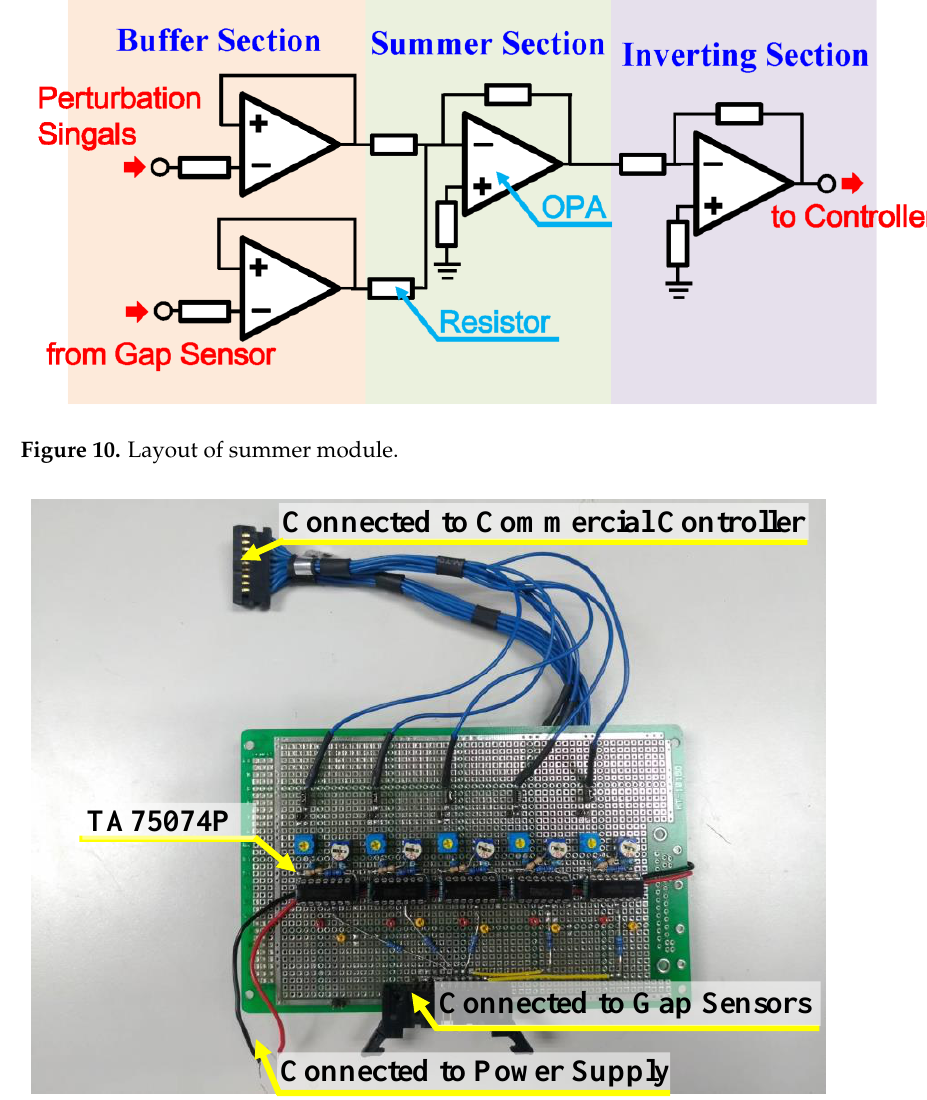
Figure 11. Photograph of summer module.